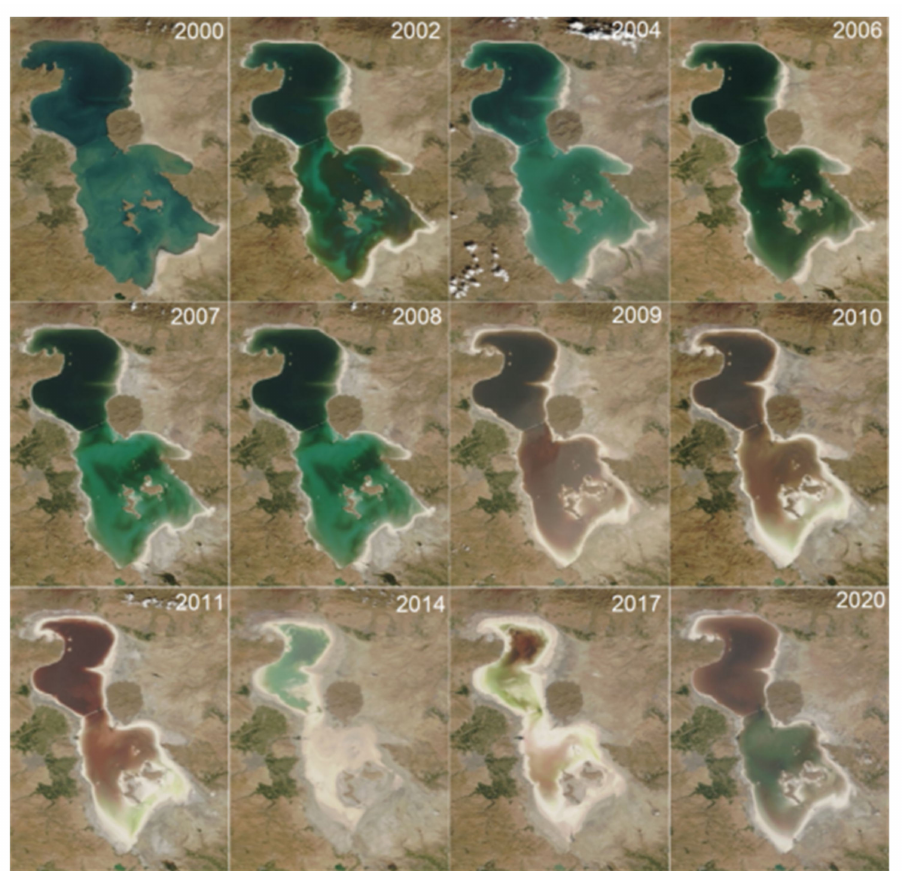
Figure 1. Desiccation of the Urmia Lake in 2000–2020. Here and after, the similar satellite snapshots were provided courtesy of NASA EOSDIS Worldview at [56].